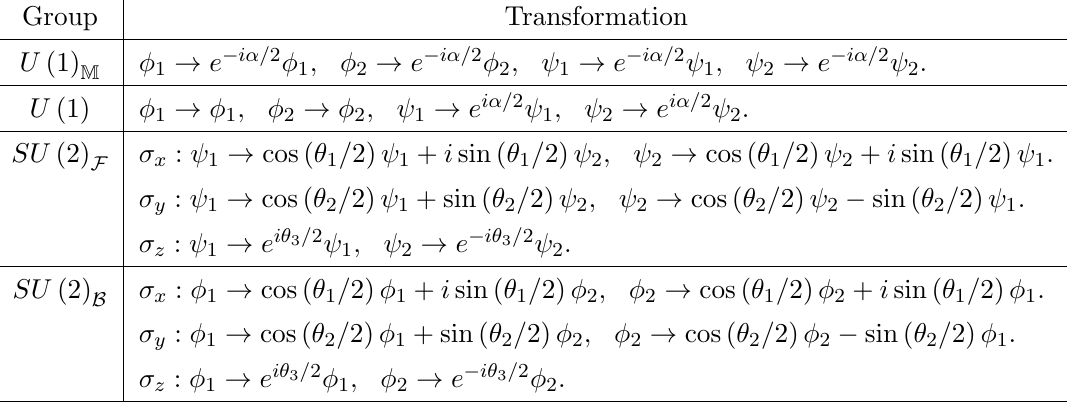
Table 1. The internal symmetries of the Lagrangian